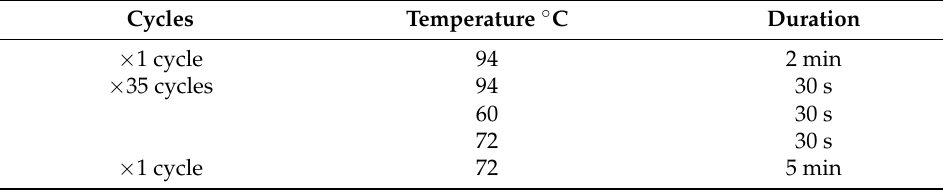
Table 6. PCR cycles for PCN species